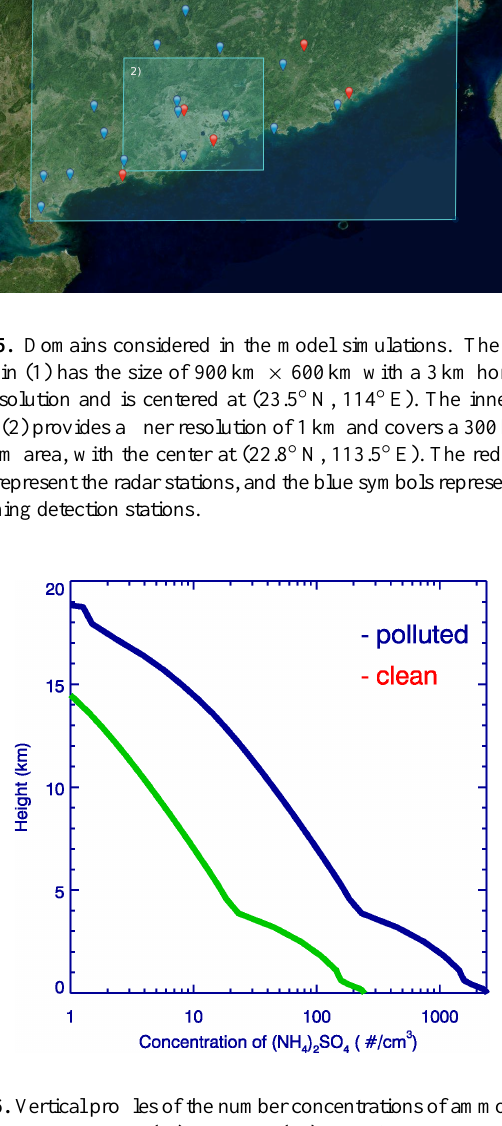
Fig. 6. Vertical profiles of the number concentrations of ammonium sulfate in the polluted (P-) and clean (C-) cases for model initializa-